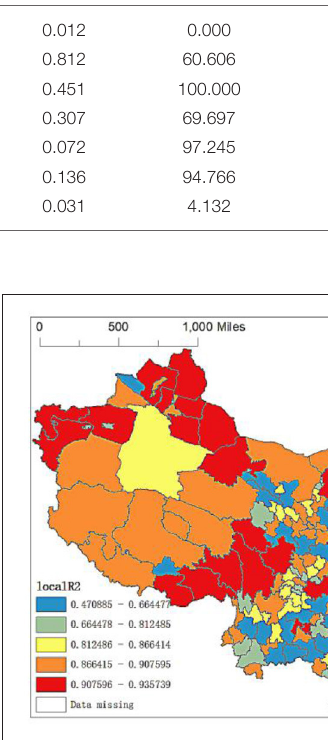
FIGURE 5 | The spatial allocation of the local R 2 of the MGWR-SAR